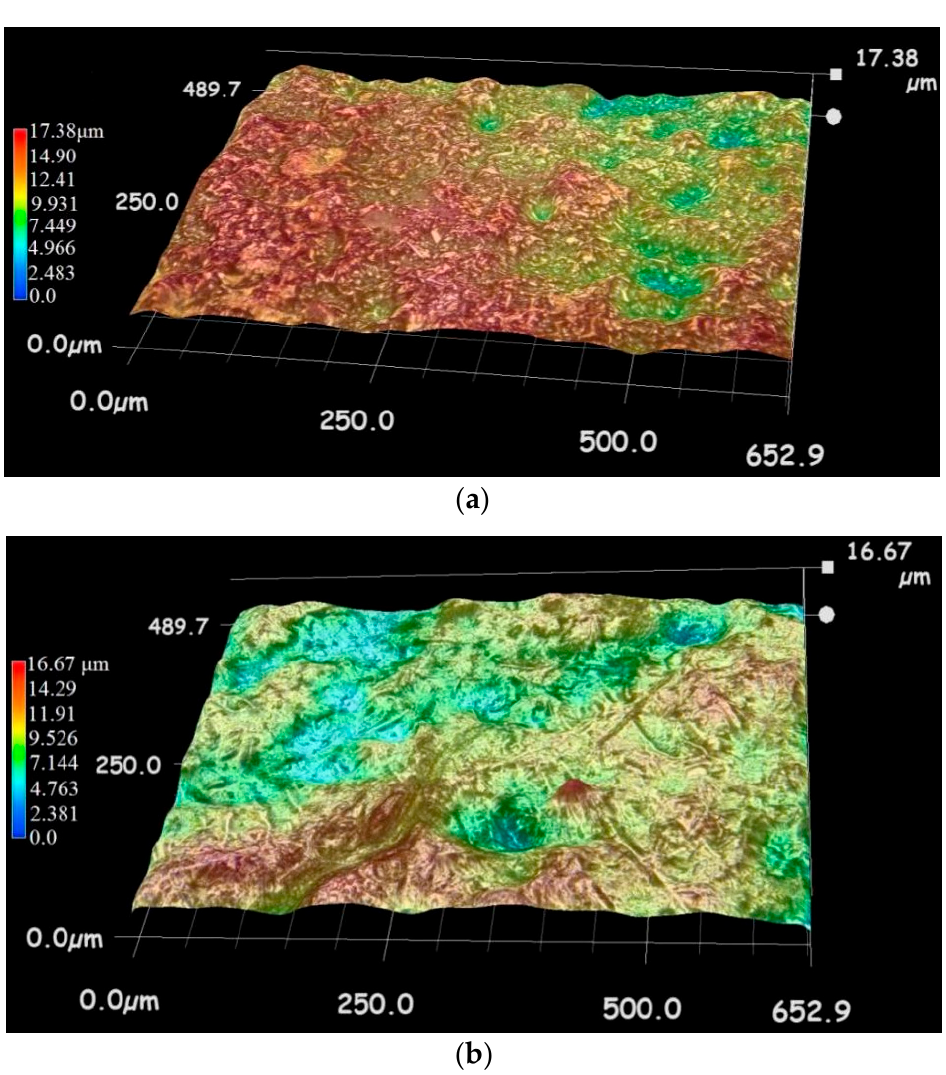
Figure 7. Influence of two-step heating methods on the 3D surface topography of Al–Si coating boron steel sheet of ( a ) Scheme A and ( b ) Scheme B.